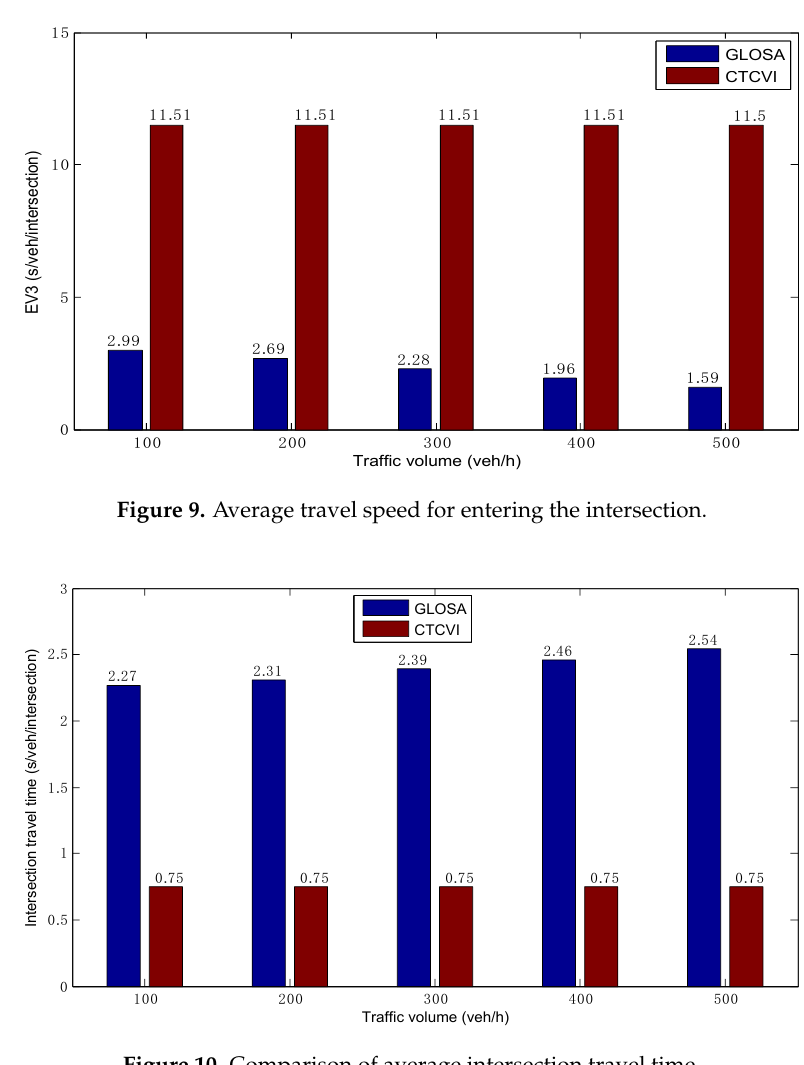
Figure 10. Comparison of average intersection travel